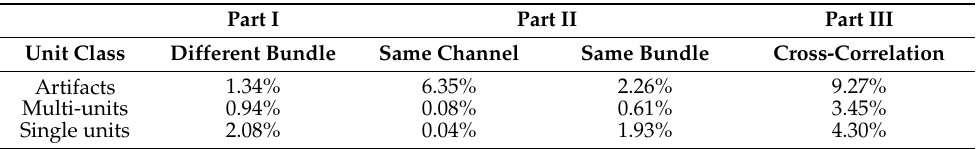
Table 5. Total percentage of spike events detected within each part of the DER algorithm (percentage of all extracted 22 341 989 spike